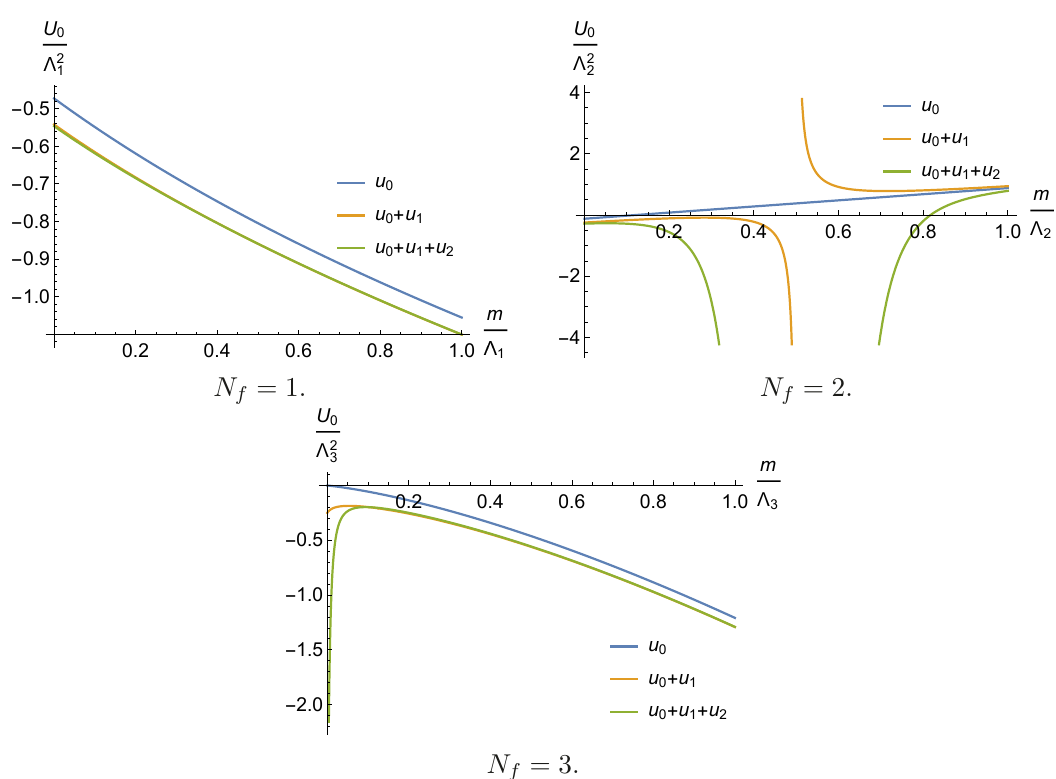
Figure 1 . The graphs of u 0 , u 0 + ~ 2 u 1 and u 0 + ~ 2 u 1 + ~ 4 u 2 with respect to m/ Λ N and 3 where we choose ~ =